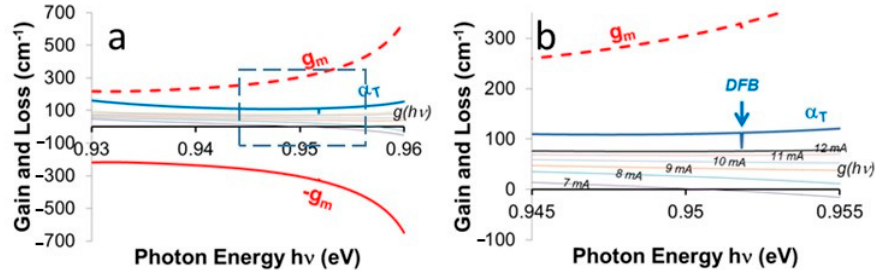
Figure 10. ( a ) Gain, loss and absorption spectra for the device under test; ( b ) detail of the boxed area in a).